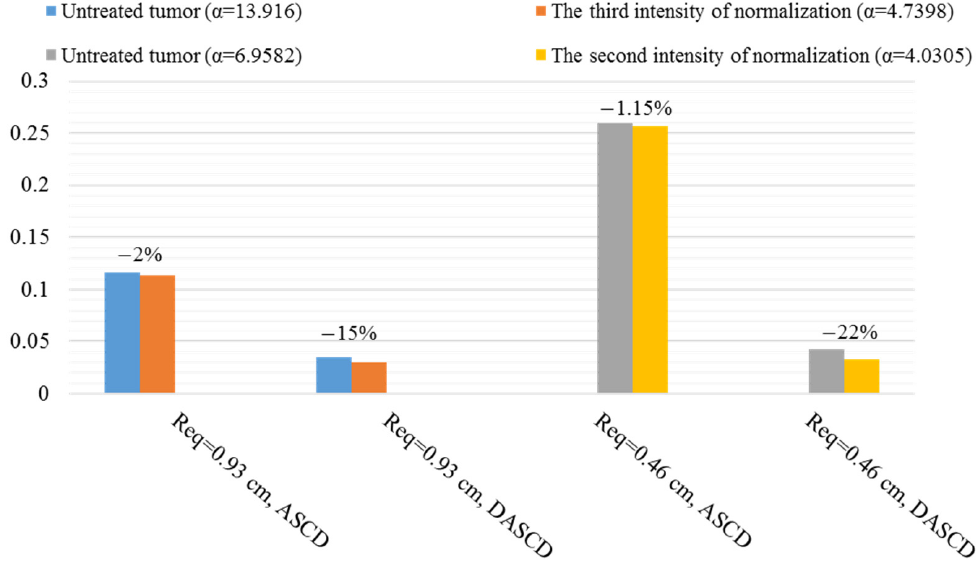
Figure 16. Summary of the positive influence of normalization on ASCD and DASCD of IgG in different sizes. The percentage of change after applying the AAIN is seen above the bars.